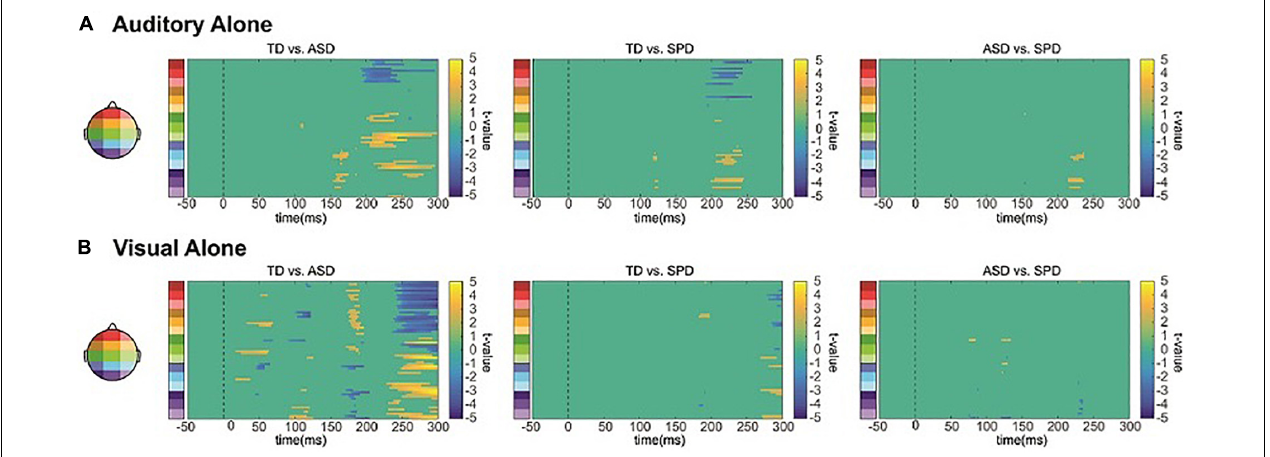
FIGURE 6 | Unisensory SCPs. (A) Statistical cluster plots comparing the response to the auditory alone condition between the three diagnostic groups. (B) Statistical cluster plots comparing the response to the visual alone condition between the three diagnostic groups.